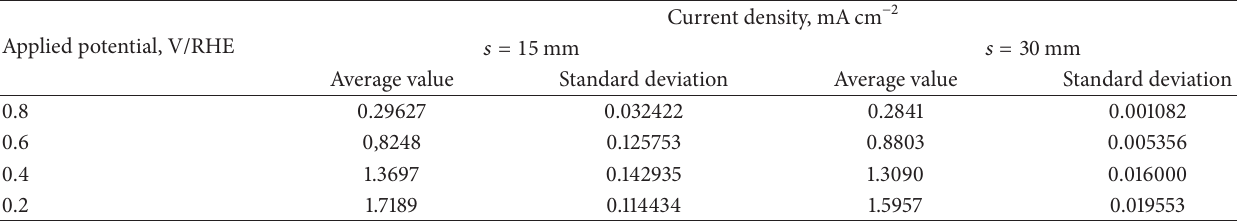
Figure 2: RDE voltammograms (scan rate: 5 mVs −1 ) in O 2 -saturated 0.1M KOH evidencing the effect of the following: poly-Pt electrode before polarization (blue curves) and quality of the RDE sliding electric contacts (red curves) (a) and 𝑠 parameter of the cell design for Mn-PPy240/G (b). The N 2 background has not been subtracted. Table 1: Repeatability of RDE voltammograms (scan rate: 5 mVs −1 ) at Mn/PPy catalyst in O 2 -saturated 0.1M KOH evaluated at 625 rpm and two 𝑠